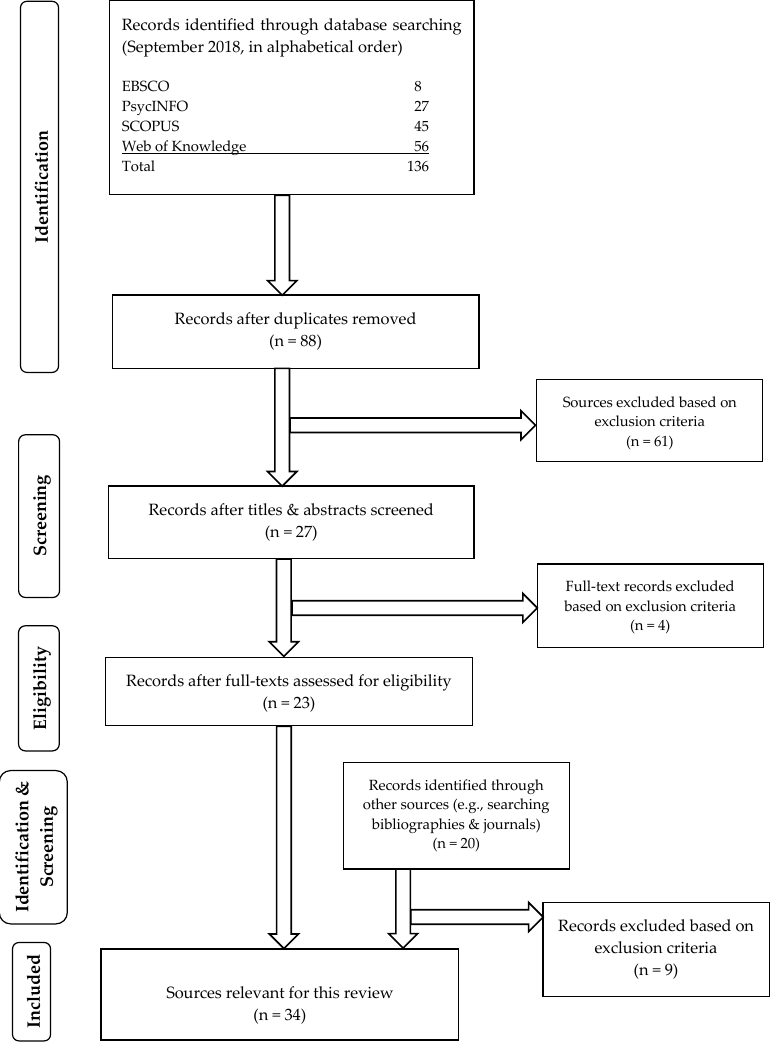
Figure 1. Flow diagram of the separate stages during the selection process for identification of studies eligible for further analysis (adapted after PRISMA guidelines